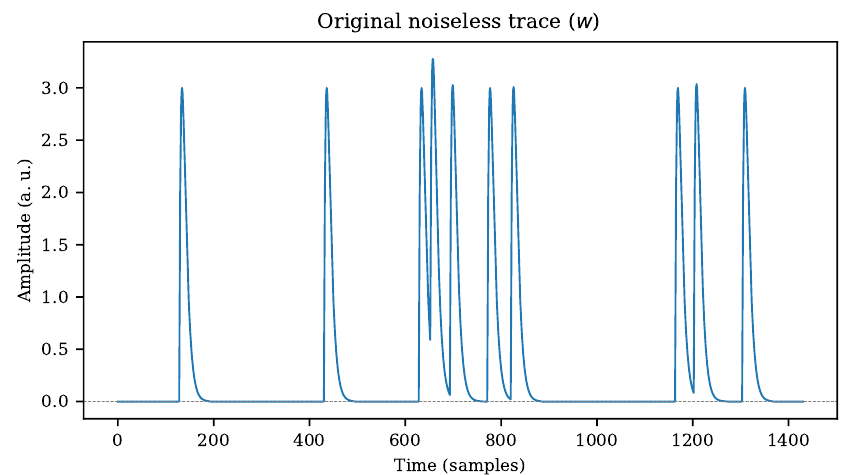
Figure 2. Noiseless trace w composed of ten individual patterns. Although individual templates were generated with the same amplitude, pile-up may occasionally cause higher peaks due to superposition of pulses.